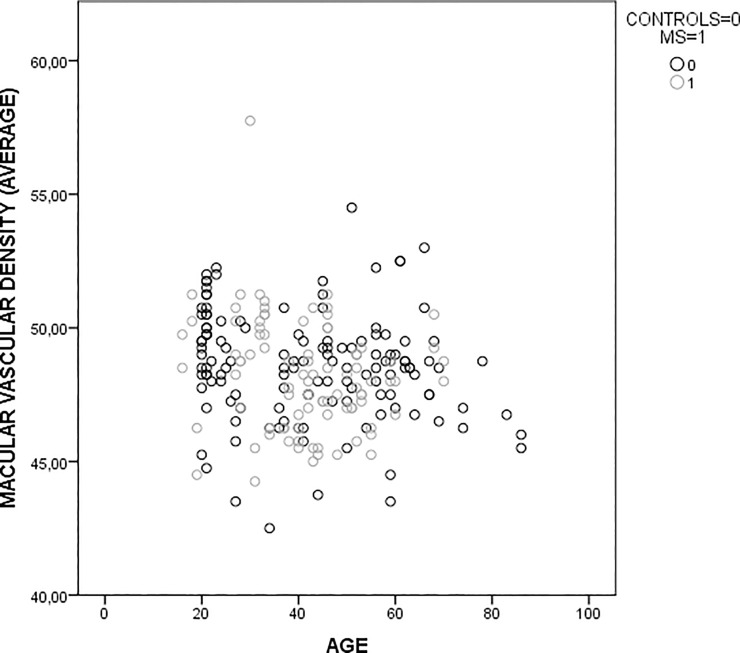
Scatterplot graphic of vascular density and age in control group and MS group.